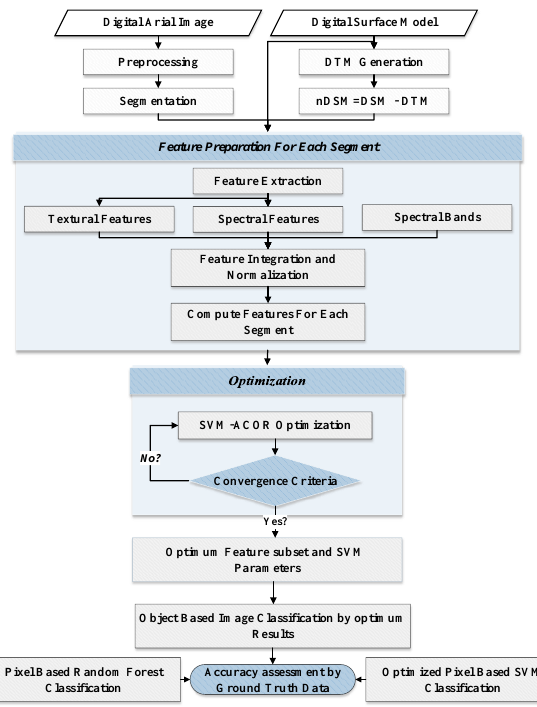
Figure 4. The flowchart of the proposed